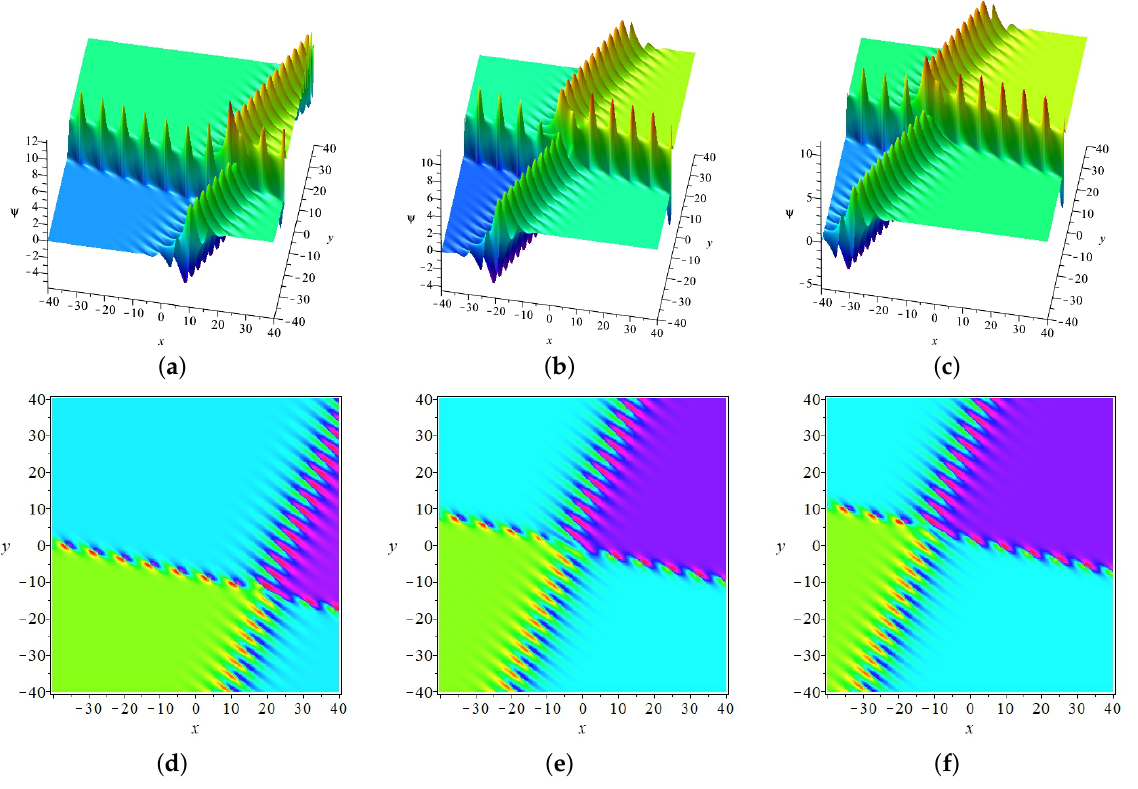
Figure 7. (Color online) The collision between non-parallel two-breather with r 2 = r 3 = r 4 = r 6 = r 7 = r 8 = 1, a 1 = 0.3, b 1 = 1, c 1 = 1.2, d 1 = − 1, e 1 = 1, f 1 = 1, β 1 = 2, γ 1 = 0, κ 1 = 0, a 2 = 0.3, b 2 = 1, c 2 = 1.2, d 2 = 0.5, e 2 = 0.5, f 2 = 1, β 3 = 2, γ 2 = 0, κ 2 = 0. ( a – c ) are vertical view when t = − 3, t = 0 and t = 1. ( d – f ) are contour